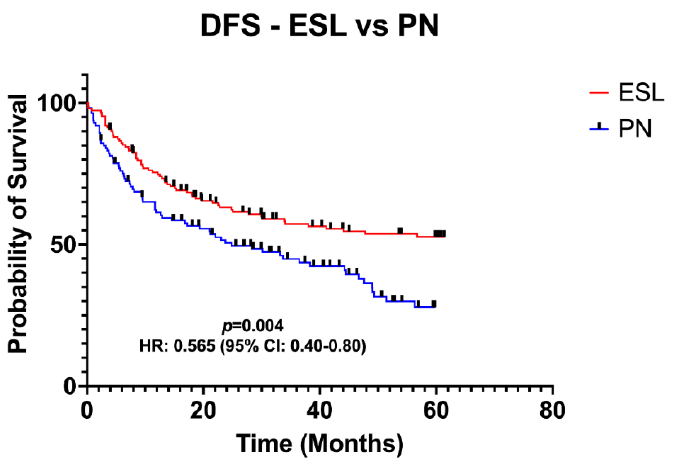
Figure 5. Pooled Kaplan-Meier curve for disease-free survival (DFS) regarding extended sleeve lobectomy (ESL) compared to pneumonectomy (PN). HR: hazard ratio; CI: confidence interval.